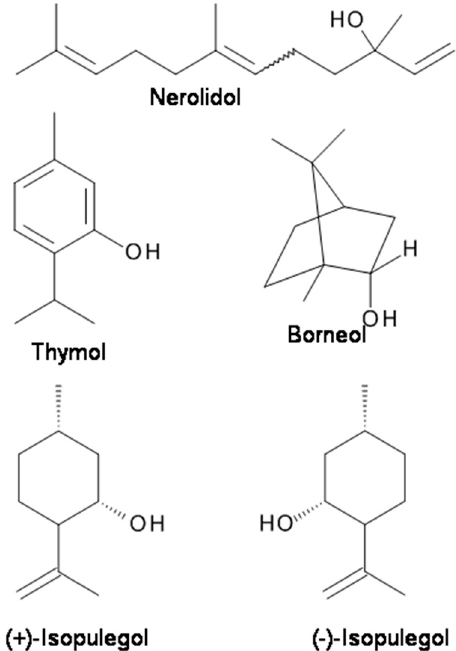
Figure 2. The chemical structures of terpenes with analgesic and anticonvulsant properties targeting GABA A receptors.